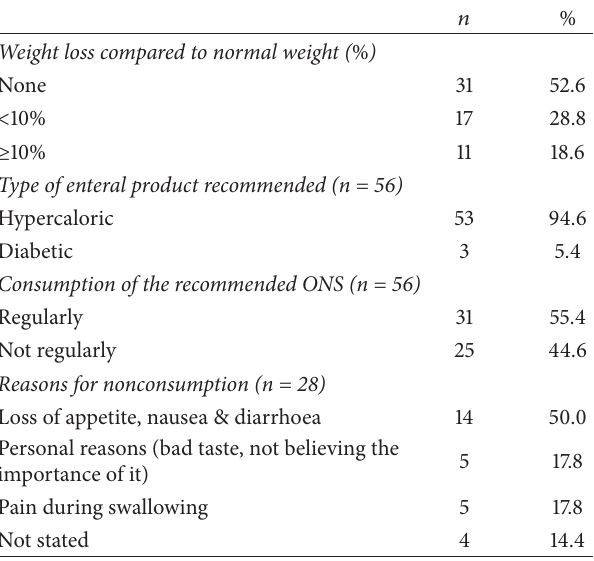
Table 2: Percent loss of weight and ONS consumption in overall study